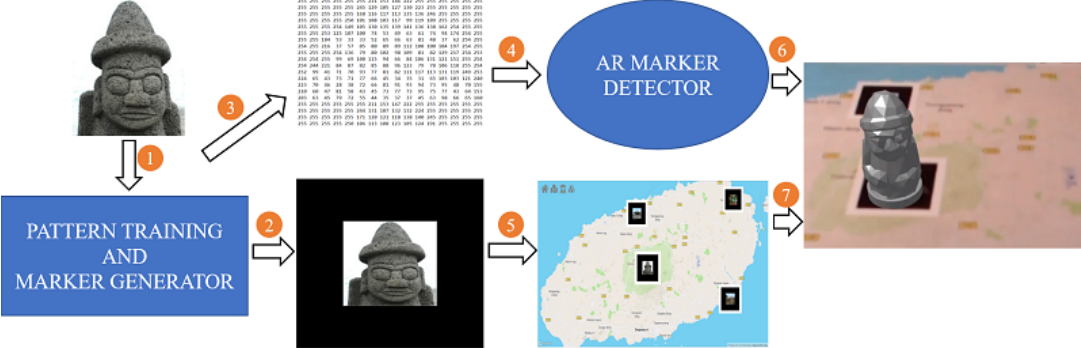
Figure 6. The printed map-making process: (1) representative image of a heritage site, (2) generated marker with augmented region, (3) marker pattern extraction, (4) AR pattern detector, (5) marker inserted into the map, (6) detector marker position, and (7) superimposed artifact on the printed